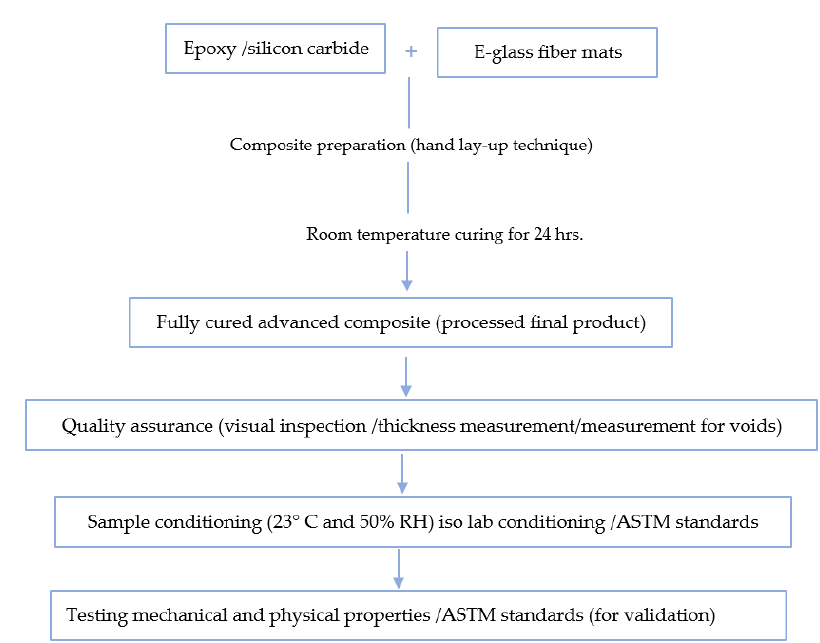
Figure 1. Flow chart for composite preparation & characterization.